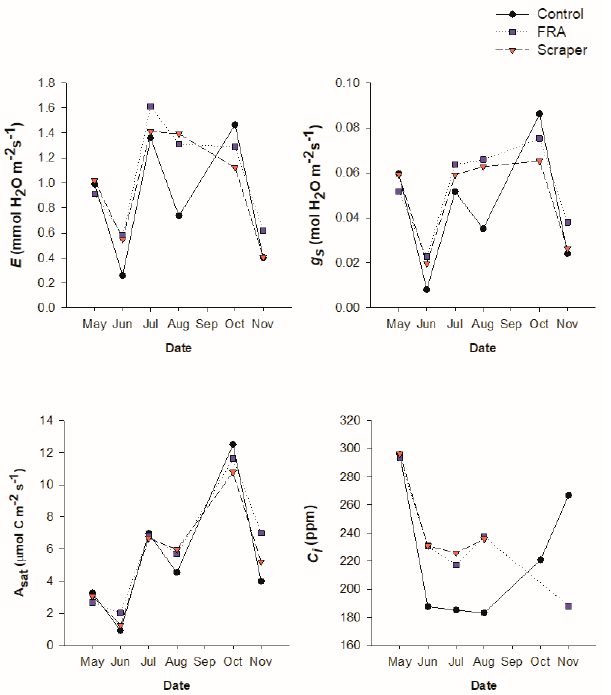
Figure 7. Leaf-level measurements taken with the LICOR 6400 XT sorted by date, treatment and variable measured. C i = intercellular CO 2 concentration; A sat = light-saturated photosynthetic rate; g s = stomatal conductance; E = leaf transpiration. Table 7. p -values of pre-dawn and mid-day mean water potential from simple linear regressions with mean leaf-level gas exchange measurements.